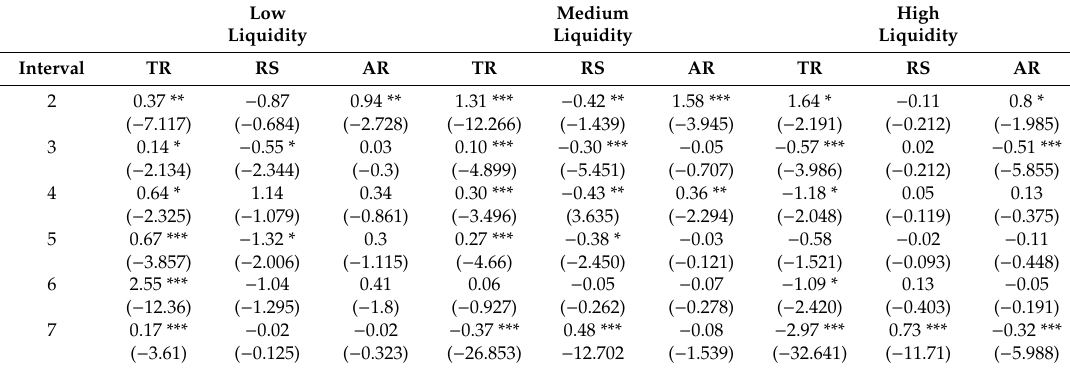
Table 2. Liquidity Measurements (%) and Abnormal Returns